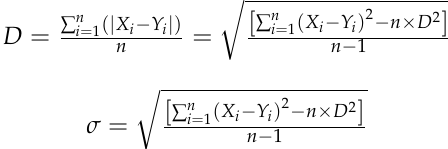
Table 2. The time of echo signal simulation.